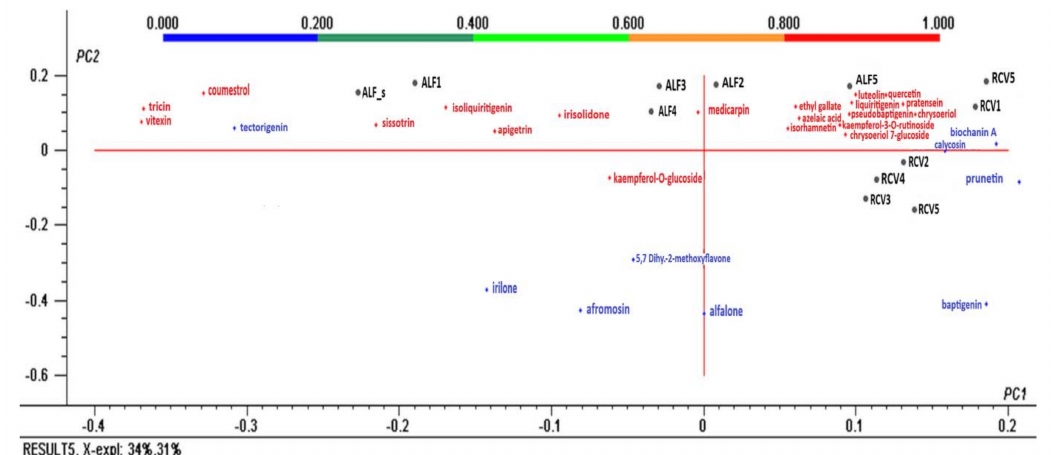
Figure 5. Bi-plot of the principal components PC1 and PC2 resulting from the PCA analysis with normalized Quatrimax rotation data of the tentatively identified polyphenols and the